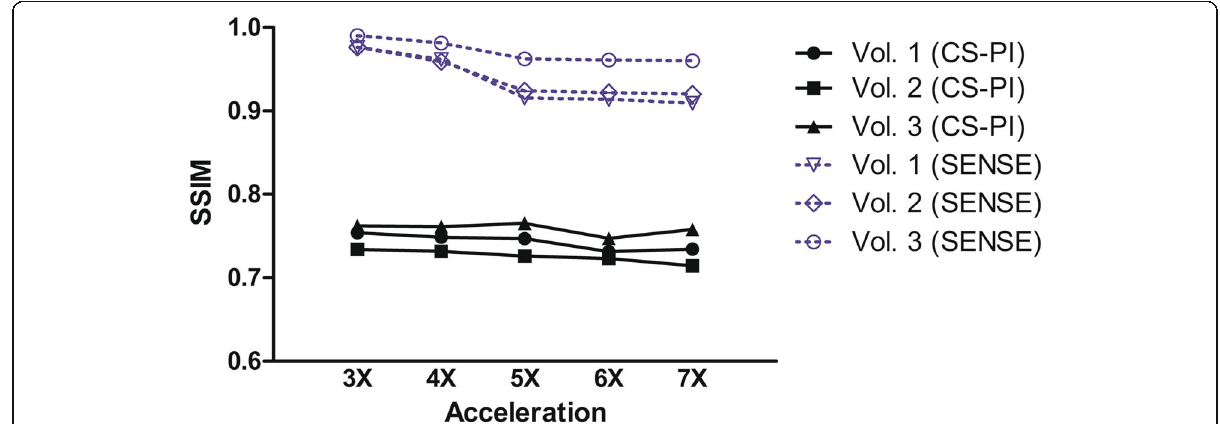
Fig. 4 The extent of similarity between the reference scan and the retrospectively undersampled scans, in the static experiment, expressed in the mean structural similarity index measure (SSIM). The mean SSIM of the compressed sensing and parallel imaging (CS-PI) reconstructions is represented with solid lines, the mean SSIM of the sensitivity encoding (SENSE) reconstructions with dotted